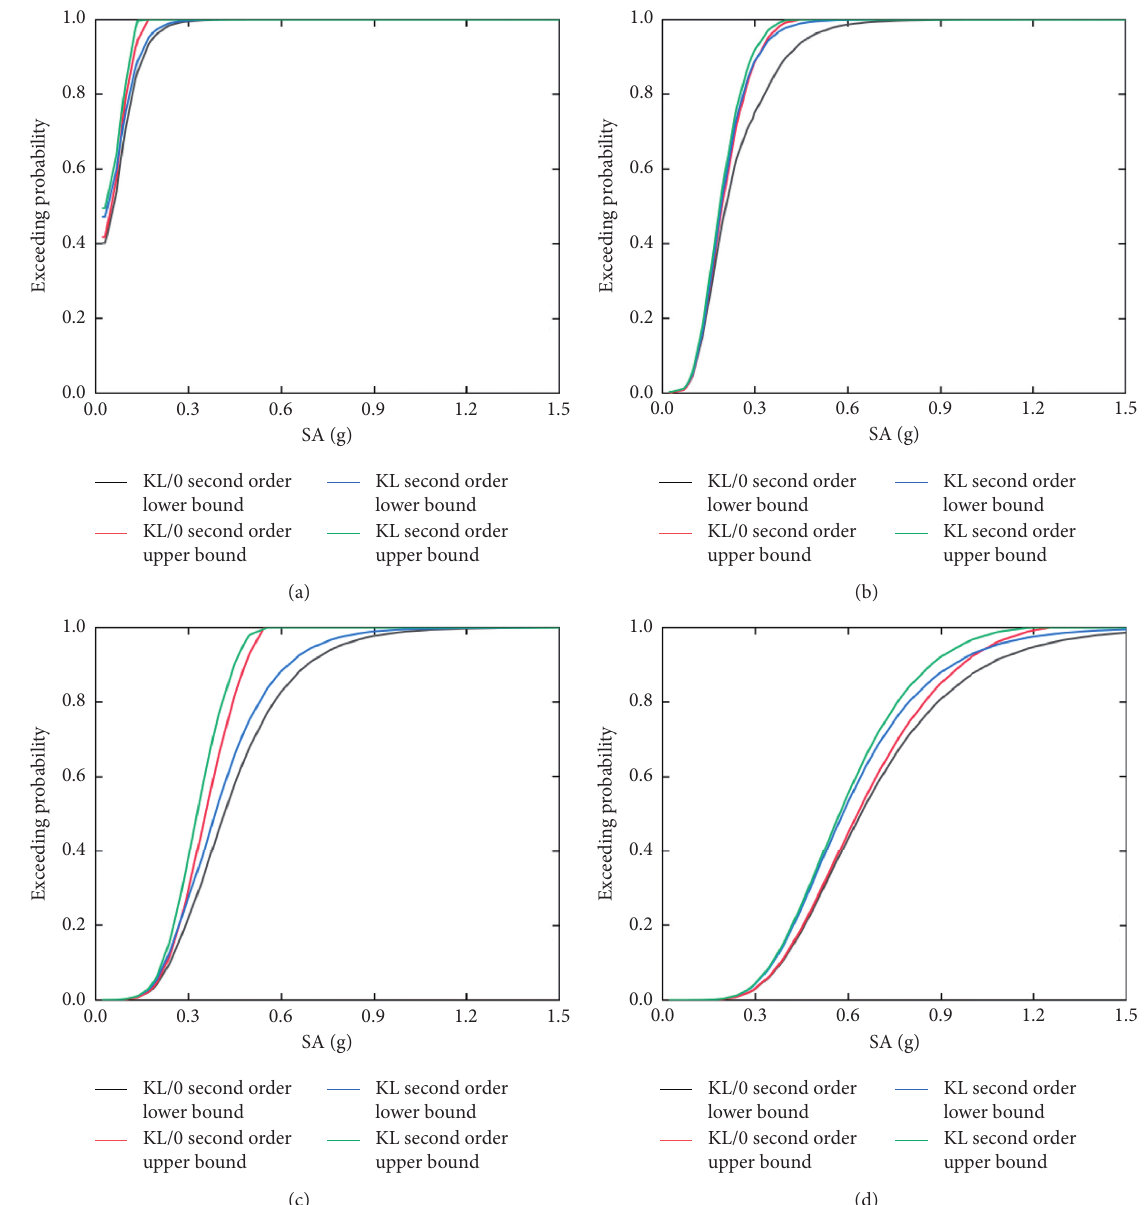
Figure 9: Fragility curves of system. (a) Minor damage. (b) Moderate damage. (c) Extensive damage. (d) Complete